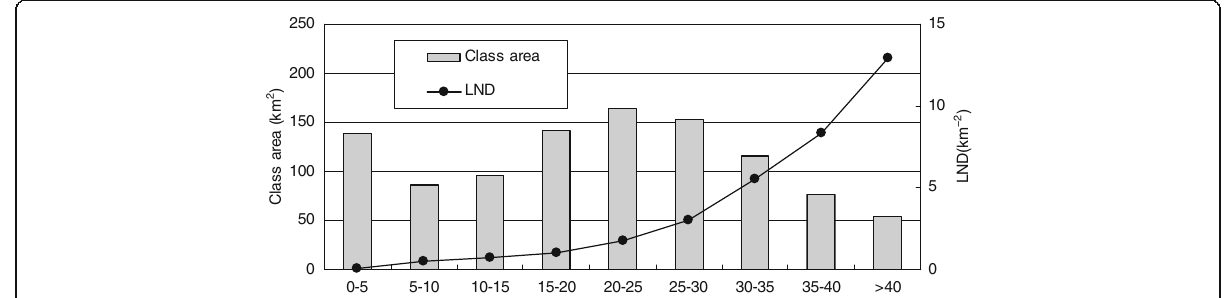
Fig. 11 Same as Fig. 10 but for slope angle ( horizontal axis, unit: degree)